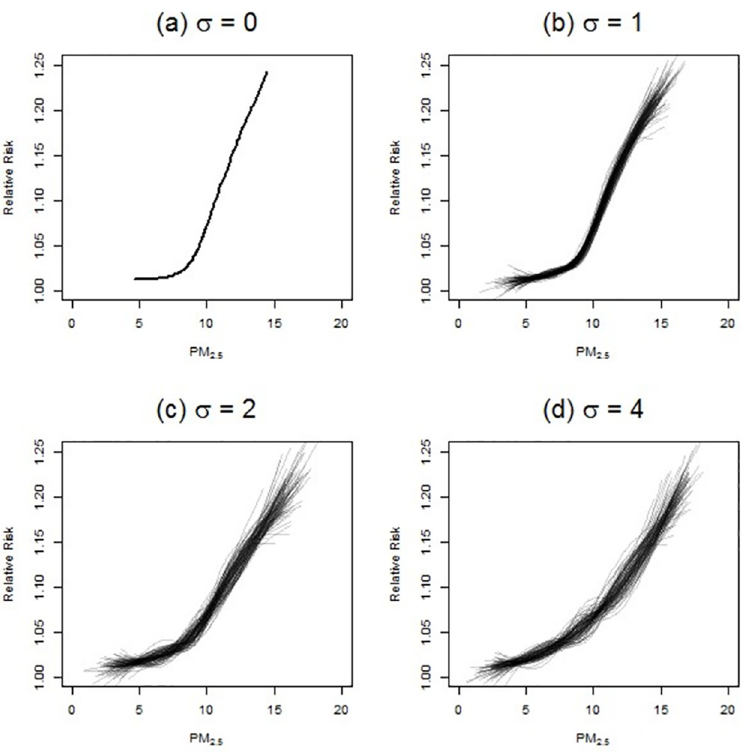
Fig 2. Spline estimates of same “true” C-R function under varying amounts measurement